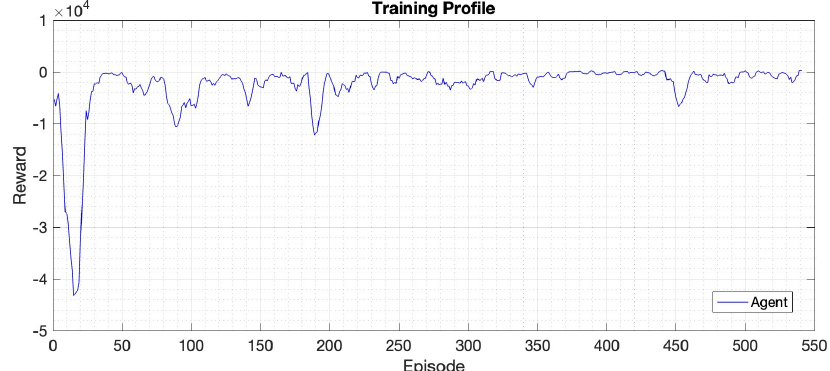
Figure 4. Training profile .